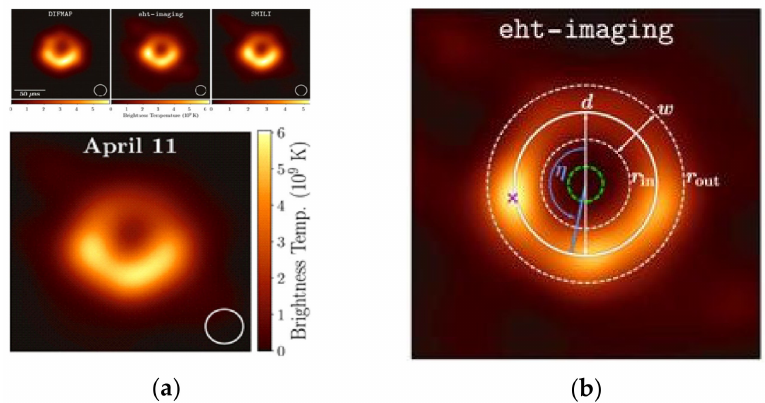
Figure 5. The first image of a black hole [11]: ( a ) Image of a black hole, created by averaging these three images; ( b ) Measurement of the various features of the black hole.